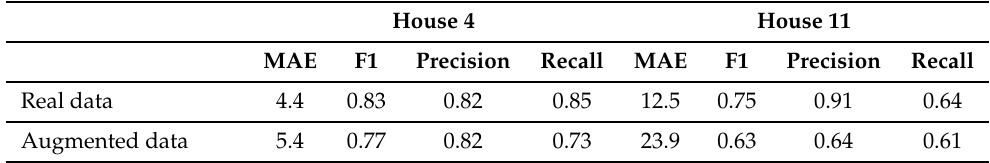
Table 7. The results of the re-evaluation of the UNET